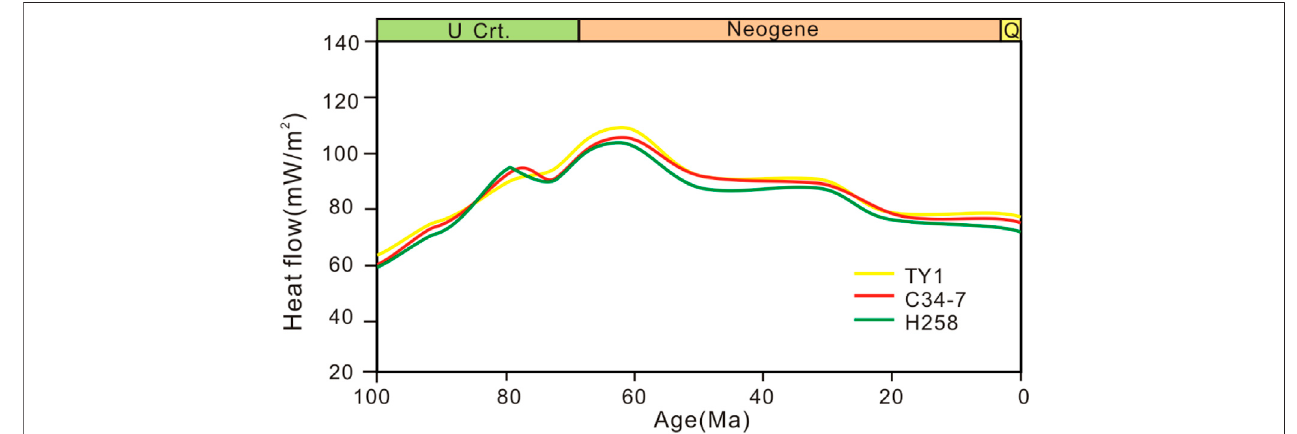
FIGURE 7 | Heat fl ow history of the typical wells in the southern part of the Songliao Basin.